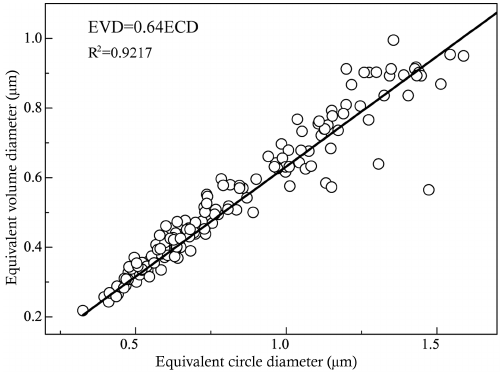
Figure 3. Correction of equivalent circle diameters (ECD) vs. equivalent volume diameter (EVD) of 194 aerosol